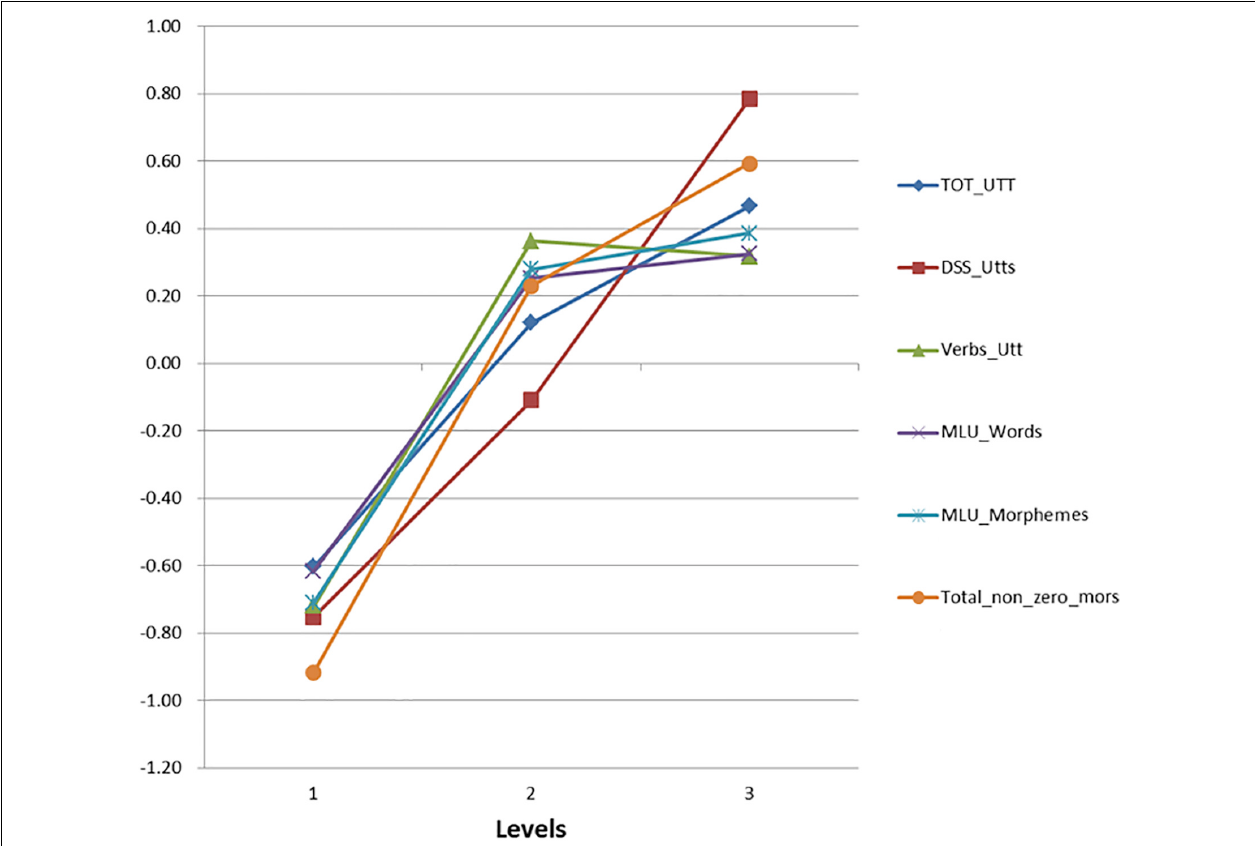
FIGURE 1 | Means of the Z -score of syntactic indicators among the three levels. TOT_UTT, total number of utterance; DSS_utts, number of DSS-eligible utterances; Verbs_Utt, number of verbs per utterance; MLU_words, mean length of utterance in words; MLU_morphemes, mean length of utterance in morphemes; Total Non-zero Mors, total number of non-zero